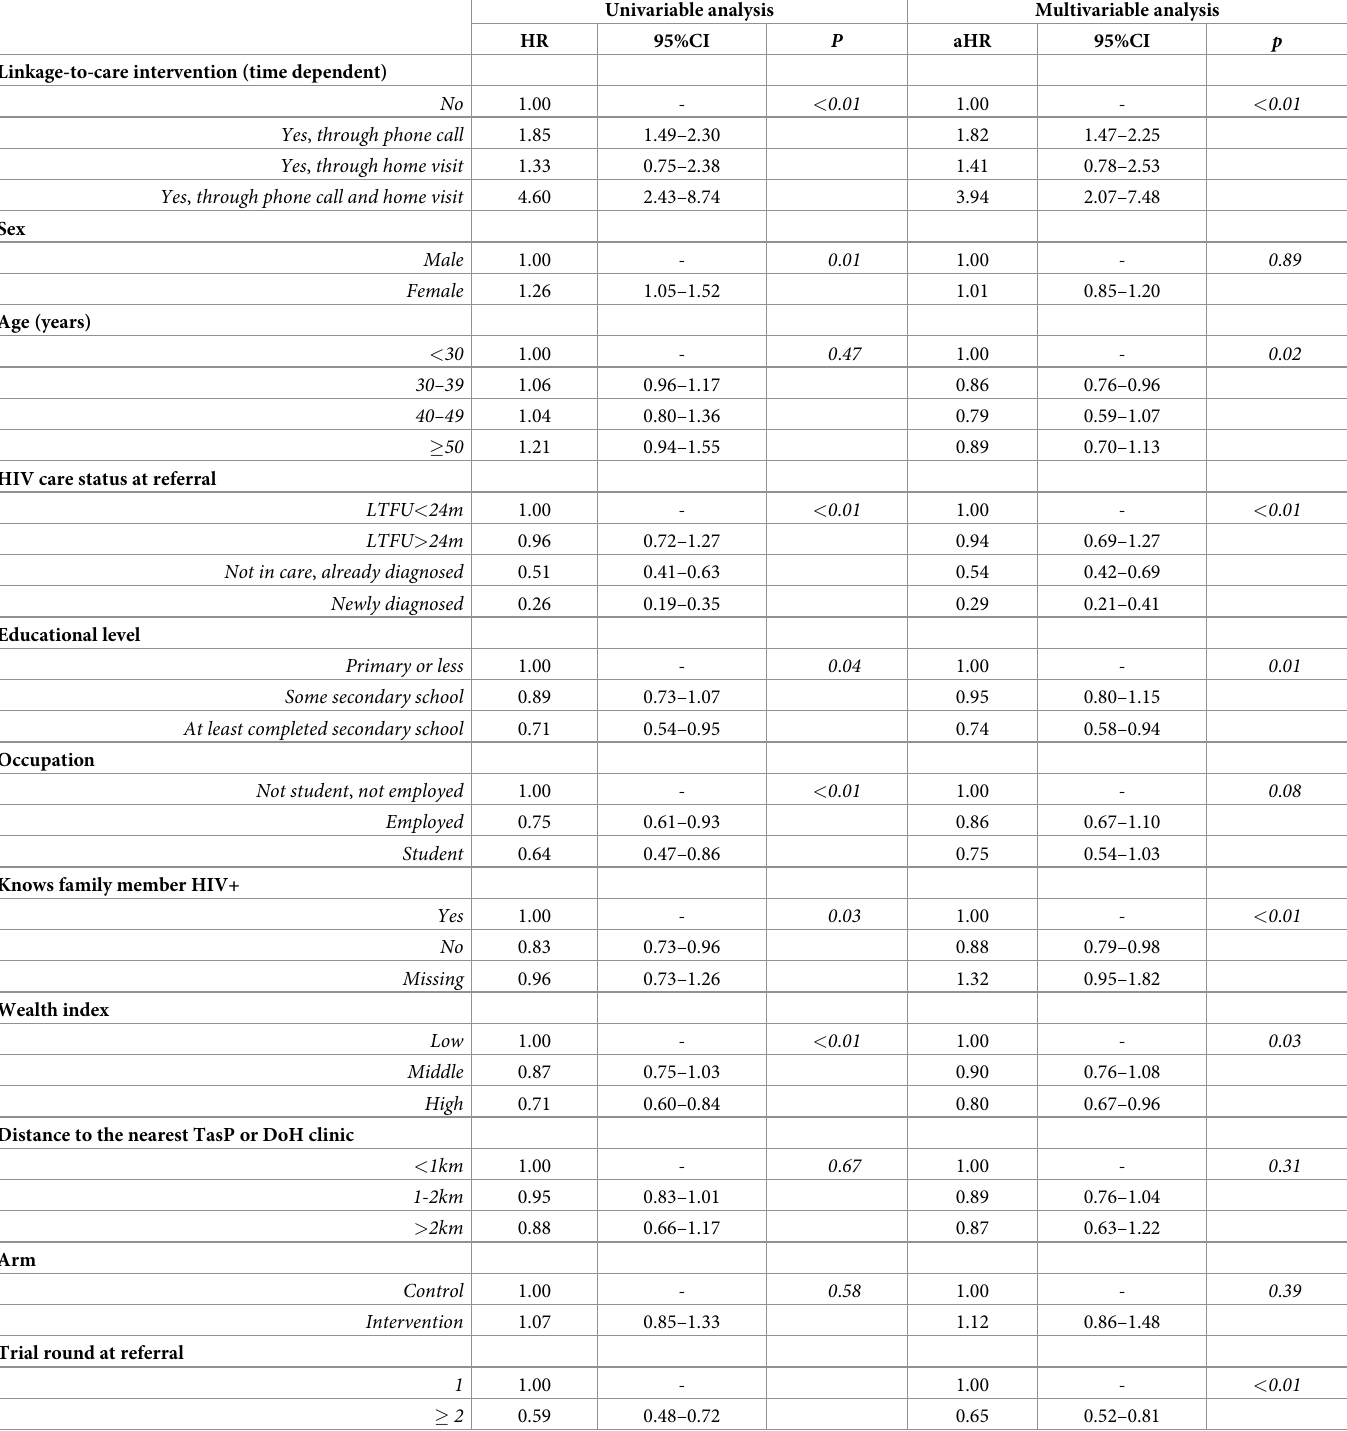
Table 2. Factors associated with time to linkage to care in a TasP or a DoH clinic (N = 2 837). Cox analysis. ANRS 12249 TasP trial.